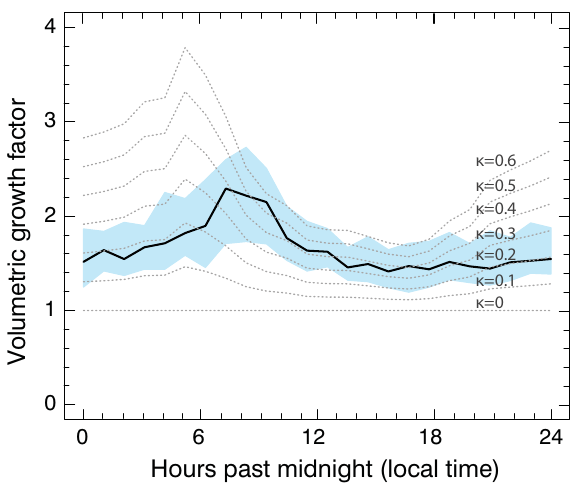
Figure 7. Diel profile of volumetric growth factor, gf vol , binned into hourly intervals. The central lines indicate the median and the shaded area represents interquartile range. Grey dotted lines indi- cating median growth factors that were calculated using the same RH and dry volume, and assumed κ values ranging from 0 to